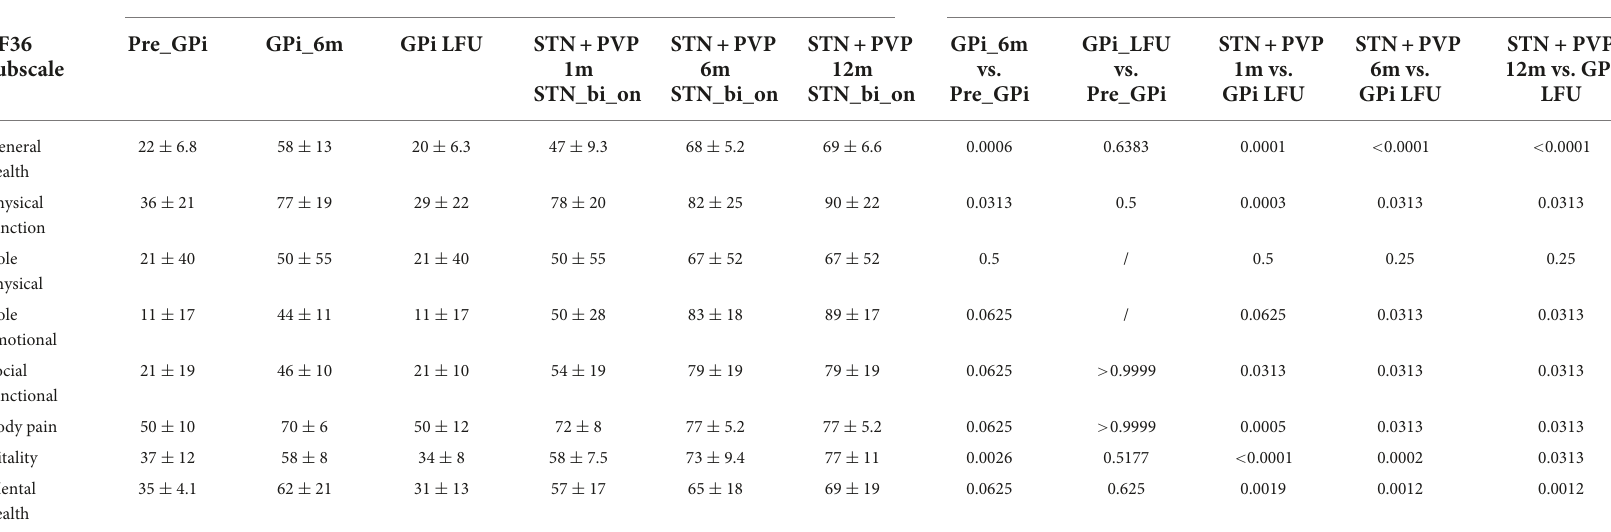
Score: Mean ± SD P -value